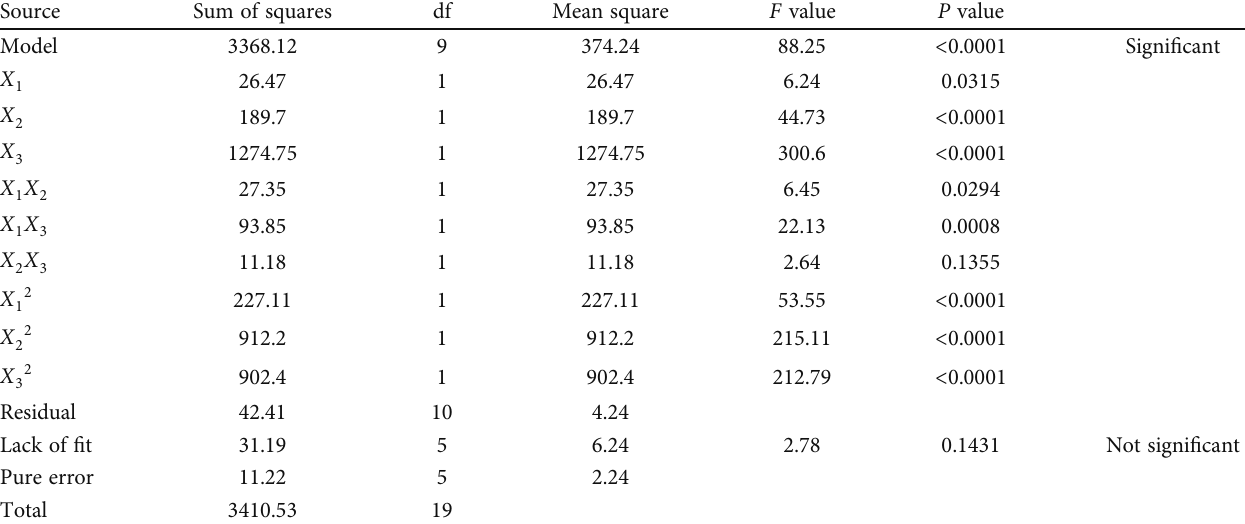
Table 5: Gadam sorghum stalks: ANOVA for testing the signi fi cance of the model equation (Source: Design-Expert 13 Software). Source Sum of squares df